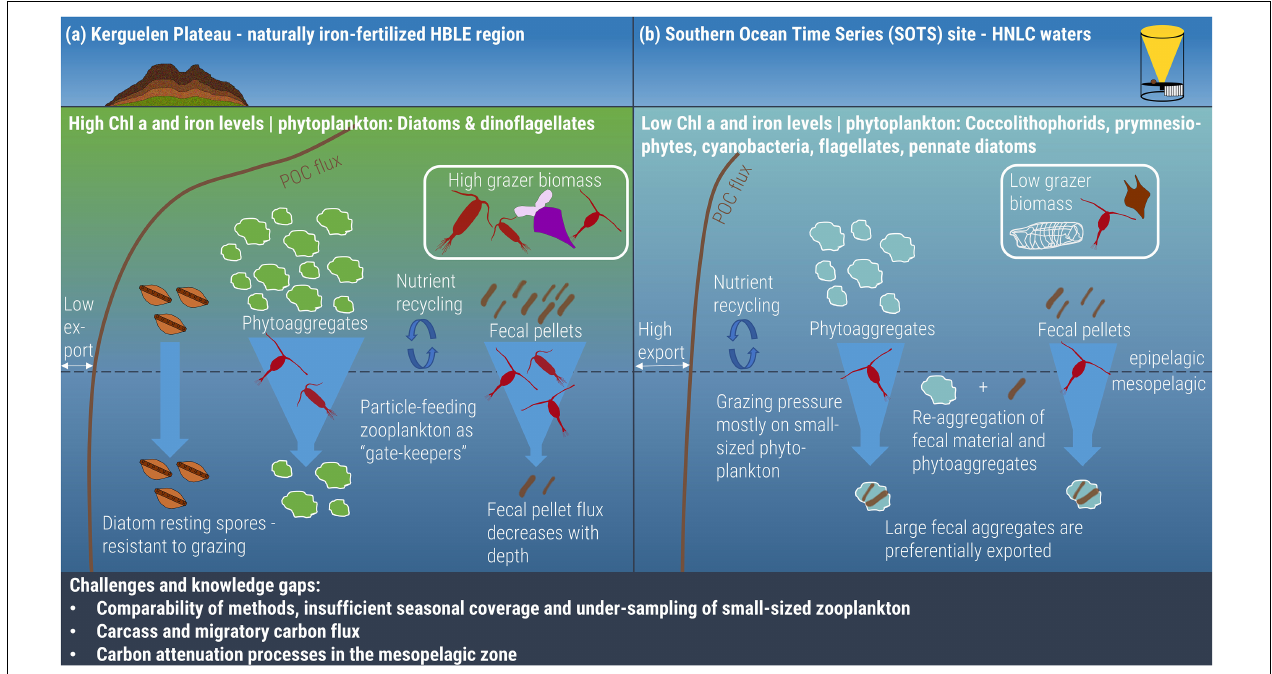
FIGURE 1 | The zooplankton-mediated carbon cycle in summer on the naturally iron-fertilized Kerguelen Plateau (a) compared to the HNLC waters around SOTS (b) . On the Kerguelen Plateau, high iron levels lead to high chlorophyll a as a proxy for algae biomass at the surface. The diverse zooplankton community feeds on the sinking particle flux and acts as a “gate-keeper” to the deeper ocean by ingesting and fragmenting sinking particles and, consequently, significantly reducing the export flux out of the epipelagic. The main export particles are diatom resting spores, which bypass the intense grazing pressure, followed by fecal pellets. At SOTS, iron levels are lower and support a more diverse phytoplankton community, but with lower biomass, which, in turn, affects zooplankton community composition and biomass. The grazing pressure during summer is focused mostly on picoplankton, which leaves large particles for export. Grazing and fragmentation of particles at both sites increases nutrient recycling in the upper water column. Challenges and gaps in knowledge in aspects of the zooplankton-mediated carbon pump are